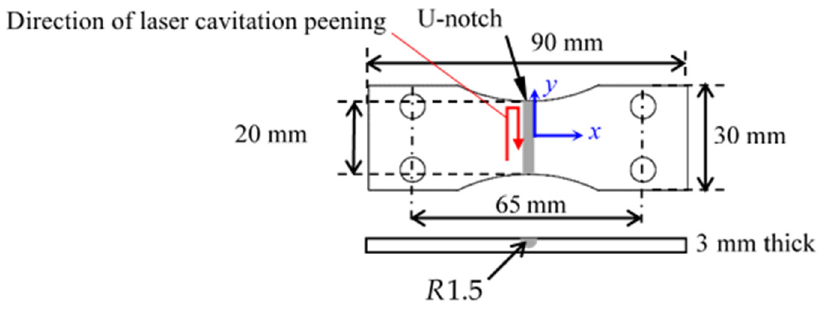
Figure 9. Geometry of the welded specimen for displacement-controlled plane-bending fatigue test, coordinates for residual stress measurement, and the direction of laser cavitation peening.